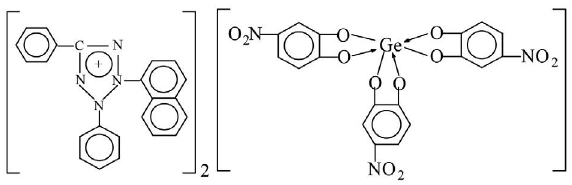
Figure 7. Structure of the ion-associated complex